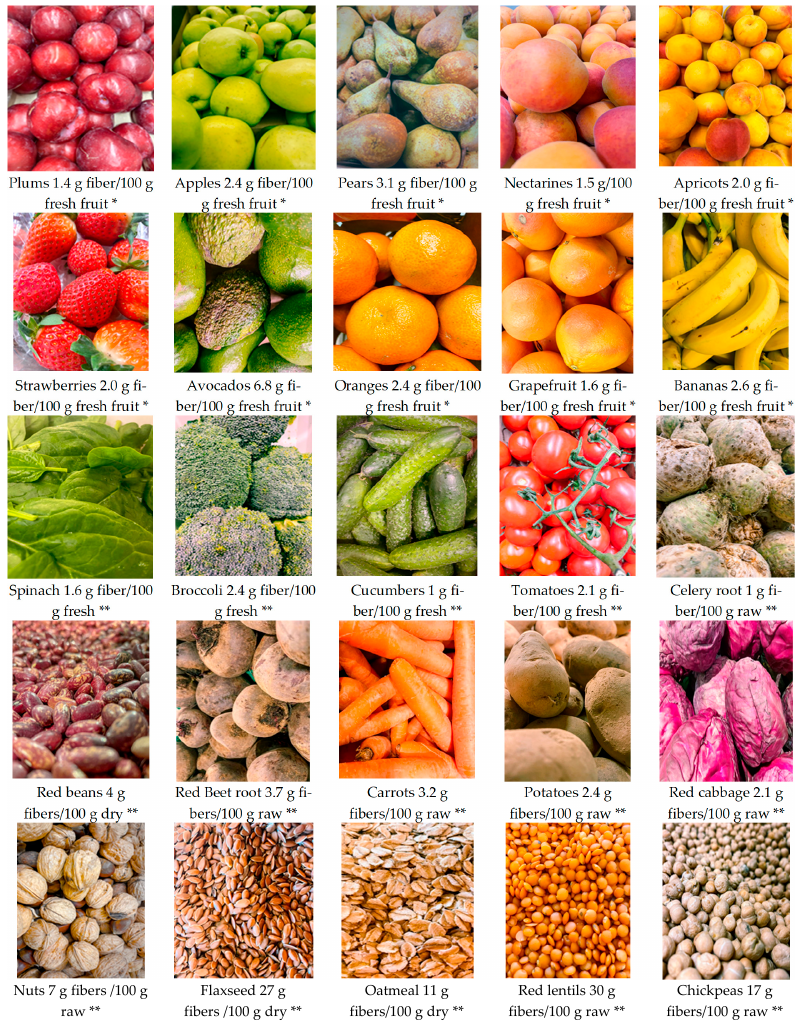
Figure 4. The estimated fiber content of certain vegetable products *—[67] and **—[68].